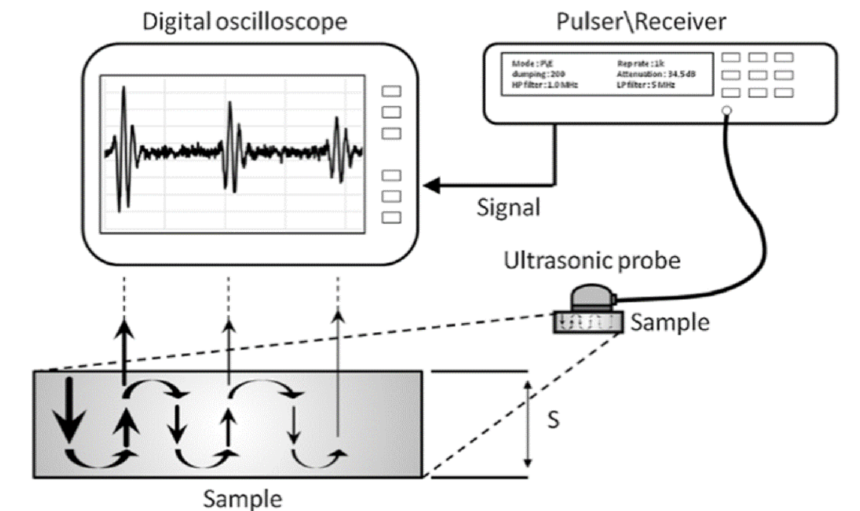
Figure 10. Typical ultrasonic non-destructive test